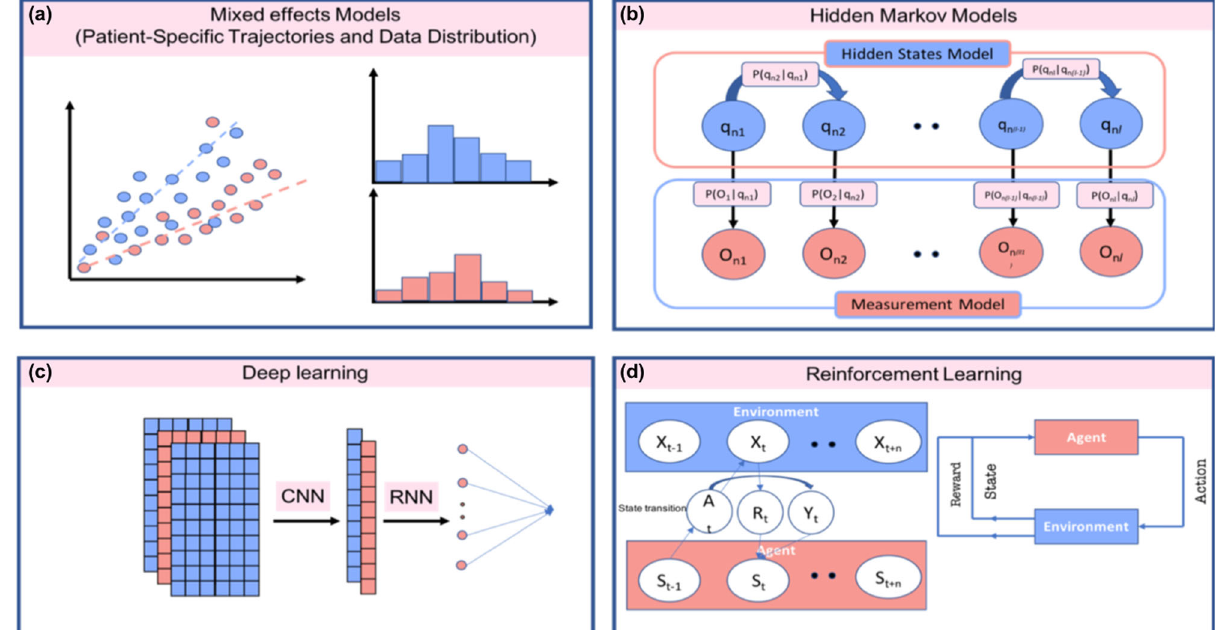
Fig. 3 Computational models for dynamic behavioral analysis and disease progression models. a Linear mixed-effect models are one of the fi rst models employed to learn patient-speci fi c data distribution and patterns. b Hidden Markov Models are statistical models for sequences of data that learn hidden states ( q ) given present observations ( O ). c Deep neural networks such as convolutional (CNN) and recurrent neural networks (RNN) learn personalized and temporal data patterns, respectively. d Reinforcement learning is an optimization model based on a reward function ( R ) relating environmental series ( X ) with predicted states ( S ) through an action ( A ), such that the cumulative reward is maximized across time ( t